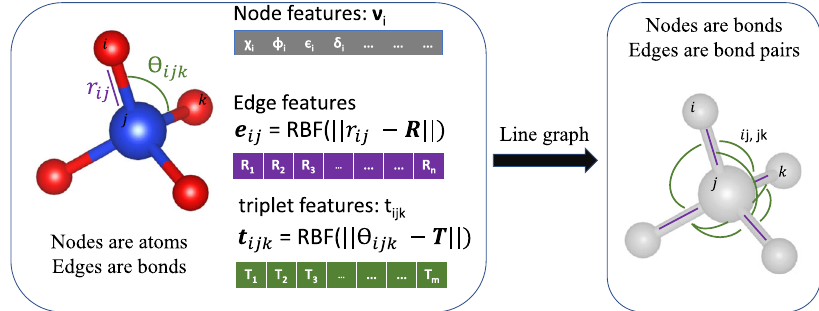
Fig. 1 Schematic showing undirected crystal graph representation and corresponding line graph construction for a SiO 4 polyhedron. For simplicity, only Si – O bonds are illustrated. The ALIGNN convolution layer alternates between message passing on the bond graph (left) and its line graph (or bond adjacency graph,